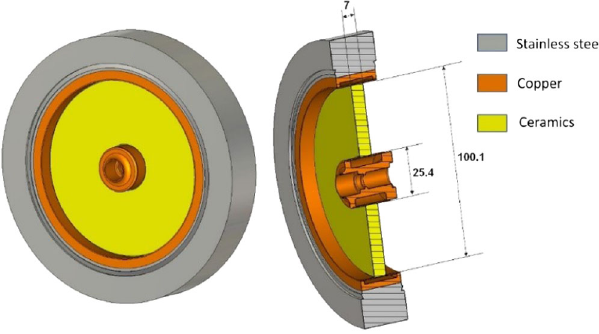
FIG. 15. Configuration and dimensions of the coupler ceramic window.